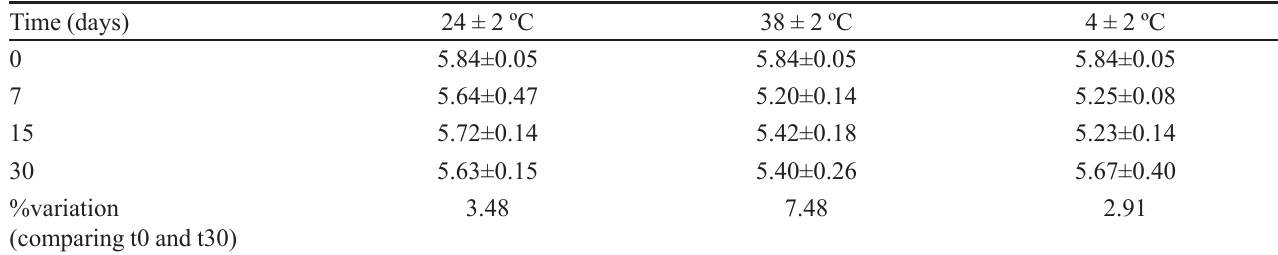
TABLE III - pH values determined during 30 days in the formulation with GB soft extract (mean ± standard deviation). The percentage of variation comparing t0 and t30 is shown